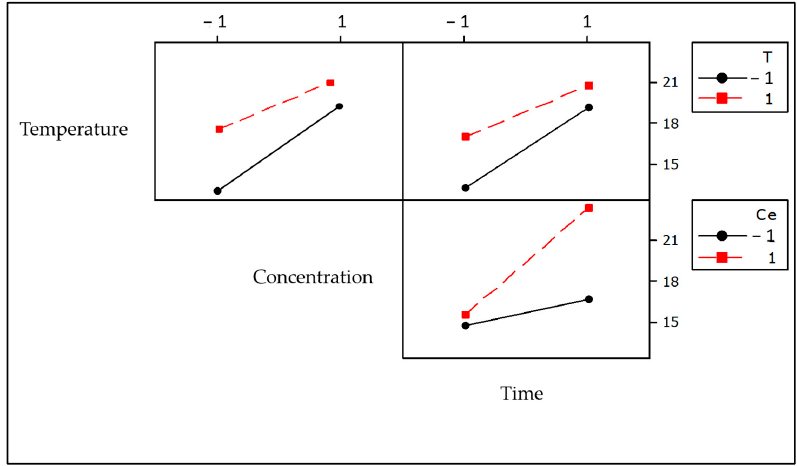
Figure 5. Interaction plots (of temperature–concentration, temperature–contact time, concentration– contact time) for the desorption of MB from the clay adsorbent coating.